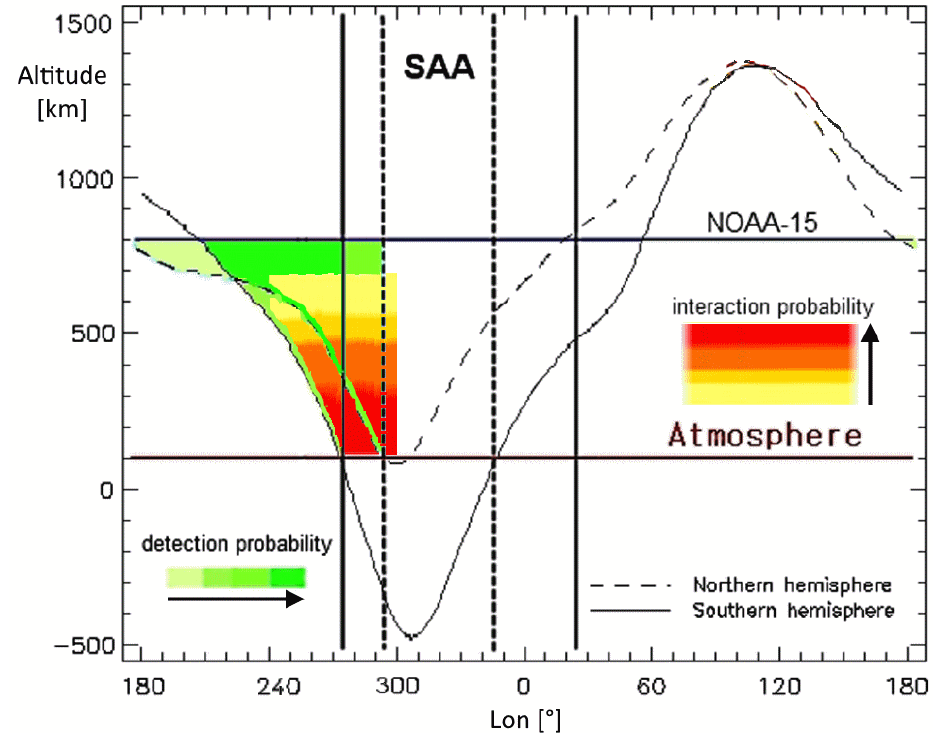
Figure 7. The electron mirror point altitudes at L = 1.2 are indicated by continuous and dashed lines, which are compared to continuous horizontal lines indicating NOAA-15 and atmosphere altitudes; green-colored areas indicate longitude regions where electrons are detectable, and the yellow to red areas indicate the probable interaction areas between EQs and EBs; arrows next to shades indicate increasing probabilities; the SAA region excluded by the analysis is delimited by vertical lines, which discriminate between the southern and the northern hemisphere using continuous and dashed lines, respectively.